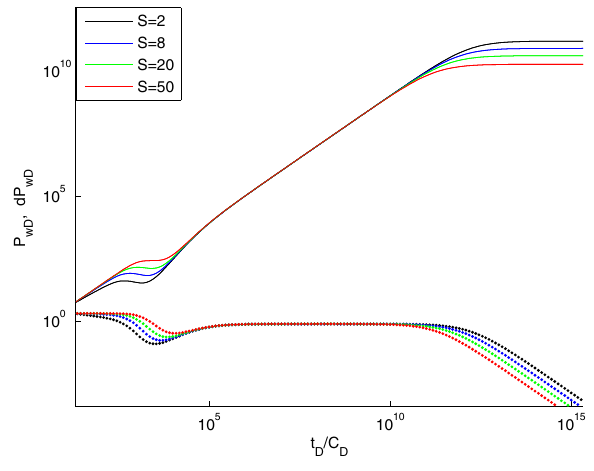
Fig. 3 Effect of S on the characteristic curves